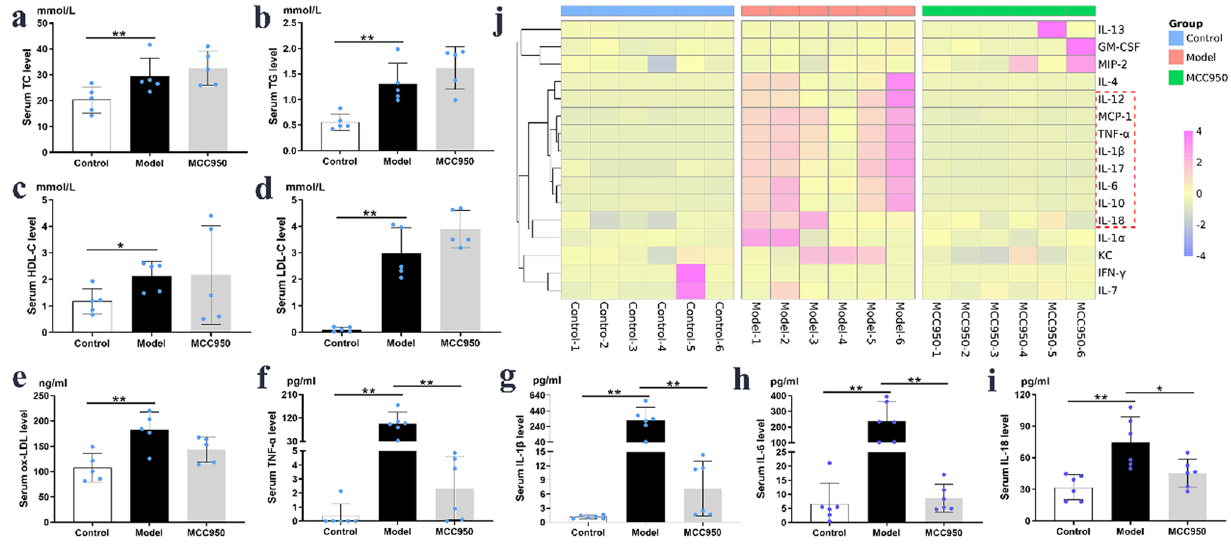
Figure 2. MCC950 reduced serum cytokines with no effect on lipid profile. The serum levels of TG, TC, LDL- C, HDL-C and ox-LDL (n = 5/group) were shown on ( a – e ). Serum concentrations of cytokines which were measured by Luminex and presented as heat map (n = 6/group; j ). Serum levels of TNF-α, IL-1β, IL-6 and IL-18 were selected from the liquid chip results and presented ( f – i ). Data were presented as mean ± SD. * P < 0.05 was considered significant, ** P < 0.01.